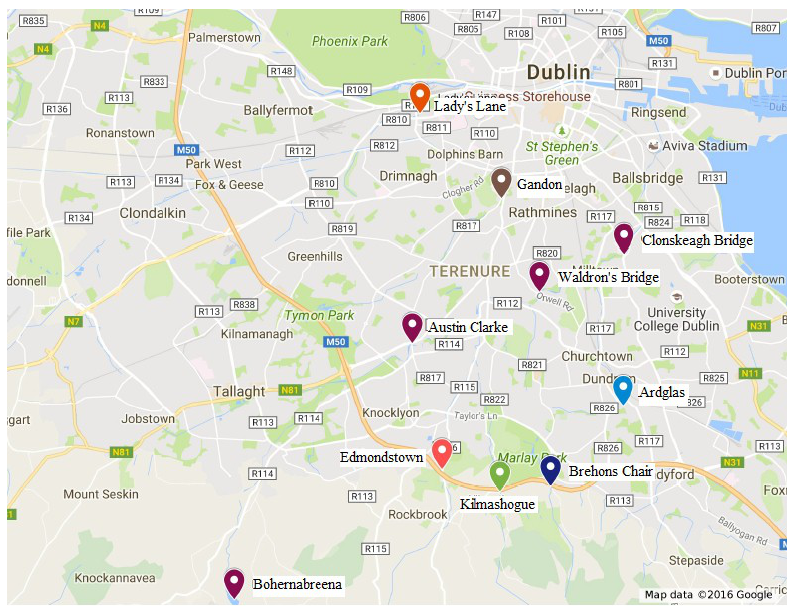
Figure 4. Locations of the ten deployed sensors on Goggle map.